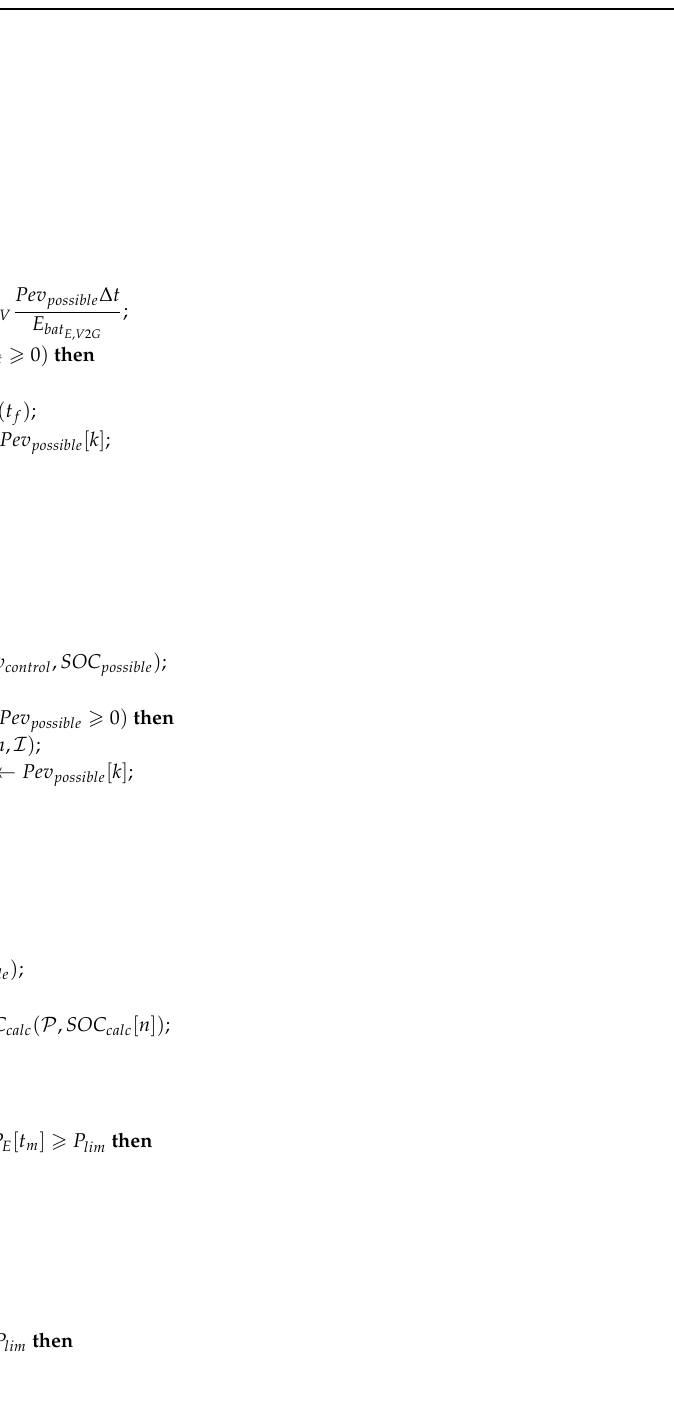
Algorithm 2: ECO and V2G